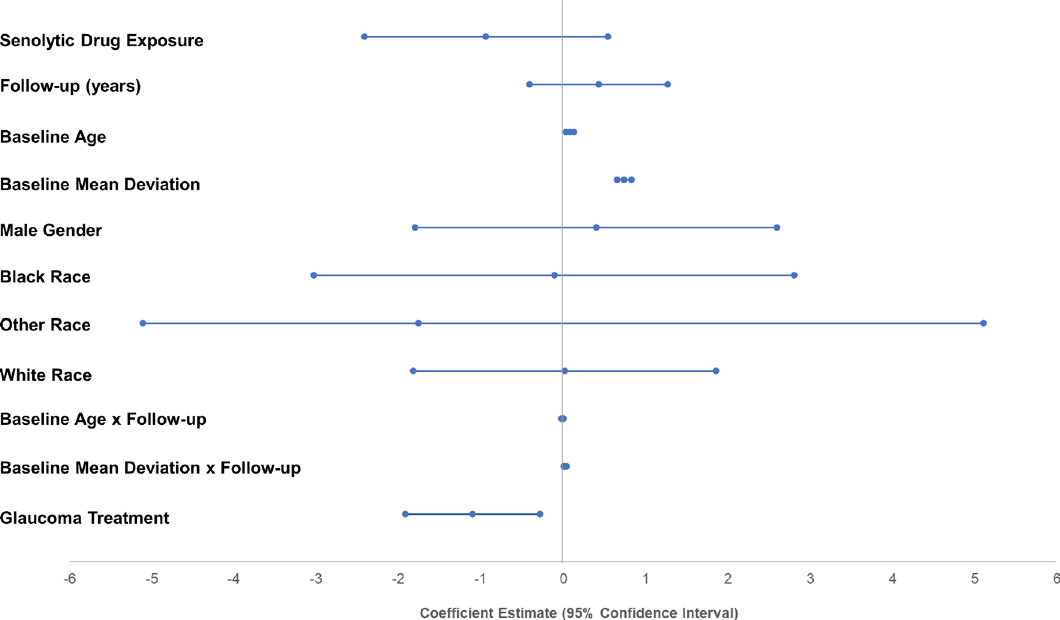
Figure 4. Mixed effects model of glaucoma progression based on changes in visual field mean deviation (MD). This plot depicts coefficient estimates and 95% confidence intervals for covariates in the model. Eyes and patients were included as random effects to account for within-subject correlation. Senolytic drug exposure (top-most interval) was not significantly associated with glaucoma progression as measured by changes in visual field MD ( p =